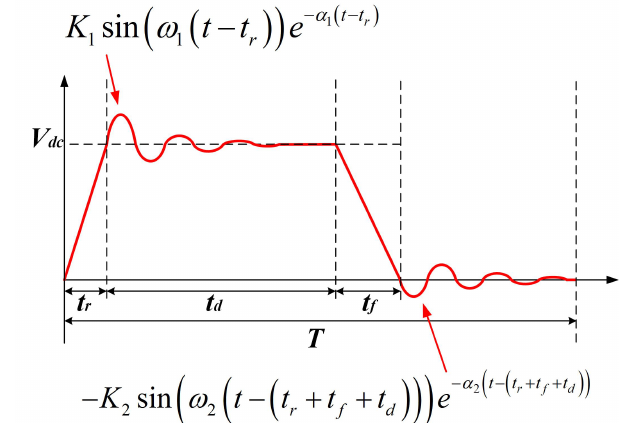
Figure 5. Analytical switching waveform of the drain-source voltage of the SiC